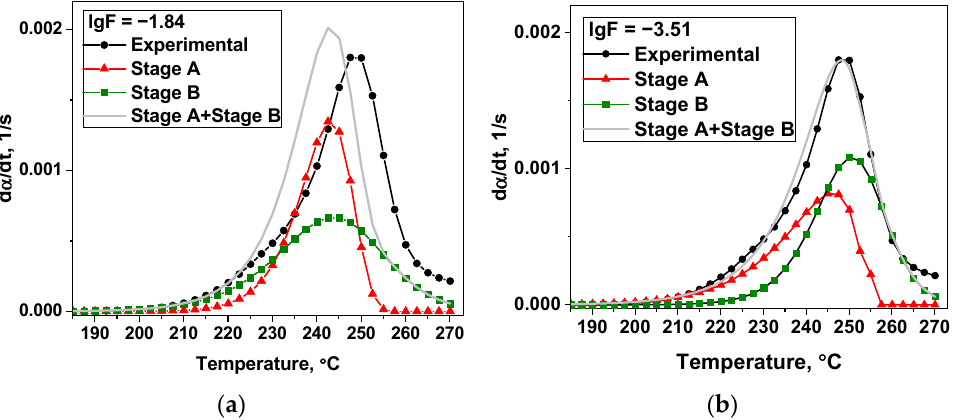
Figure 7. Prediction of DTG curve for [Ni(En) 3 ](ClO 4 ) 2 decomposition obtained at a lower heating rate of 2.5 °C·min − 1 using the models of Table 4: ( a ) variant 1 and ( b ) variant 2.